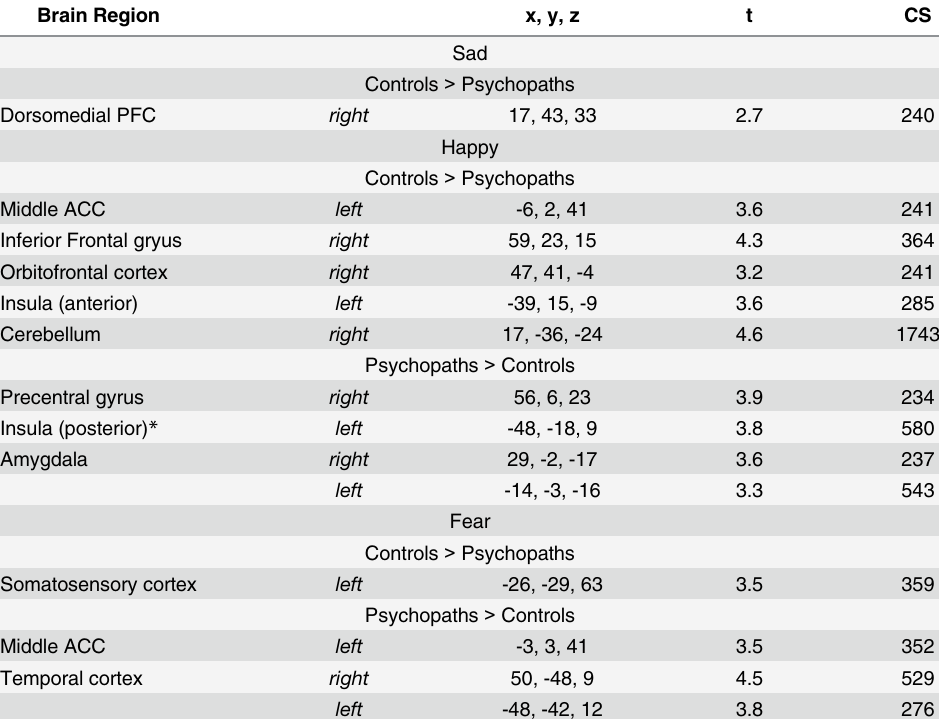
Table 3. Brain volumetric correlates of between-group differences in facial emotion recognition of sad, happy and fear expressions. Brain Region